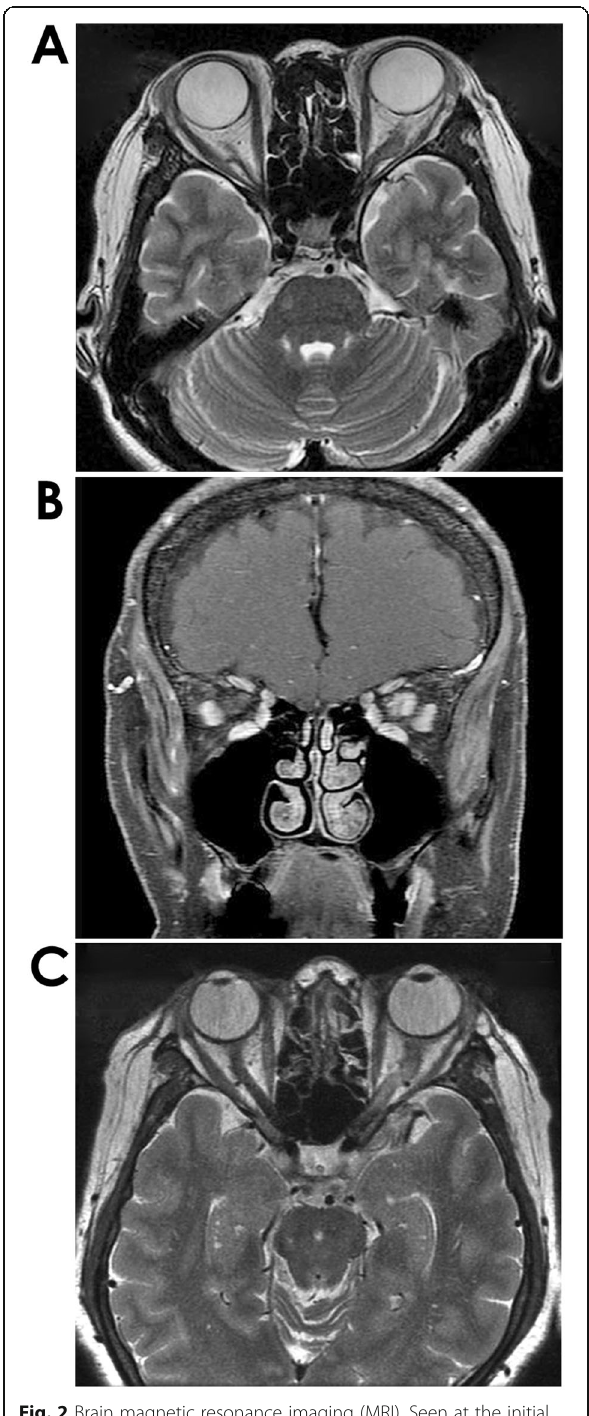
Fig. 2 Brain magnetic resonance imaging (MRI). Seen at the initial visit, the axial section revealed irregular hypertrophy of the left retrobulbar optic nerve ( a ). Moreover, the post-contrast T1-weighted image showed enhancement of the left retrobulbar optic nerve ( b ). Five months later, a T2-weighted image indicated that the hypertrophy at the left retrobulbar optic nerve was resolved ( c